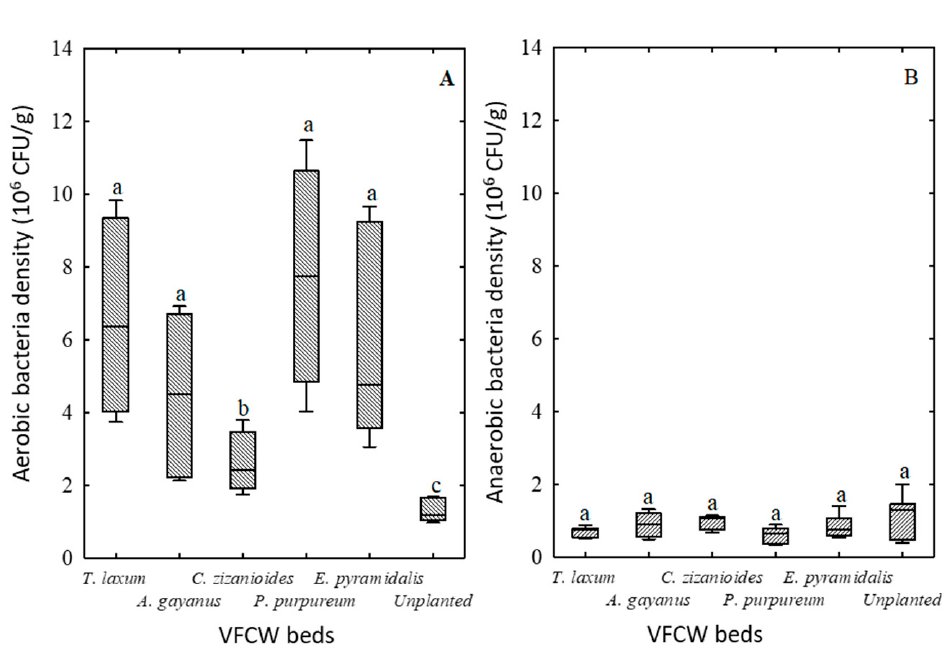
Figure 2. Variations of ( A ) aerobic, and ( B ) anaerobic bacteria densities in the pilot VFCWs substrate at the end the treatment trial. Box-plots bearing the same letter indicate no significant difference ( p > 0.05).